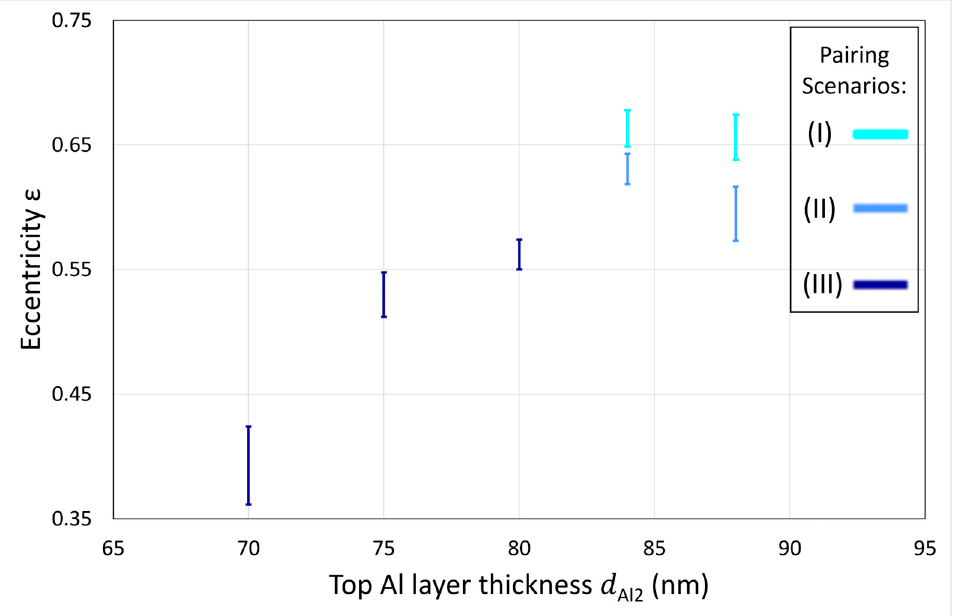
Figure 8. The eccentricity of shutter B is shown as a function of the thickness of the top Al layer ( d Al2 ).